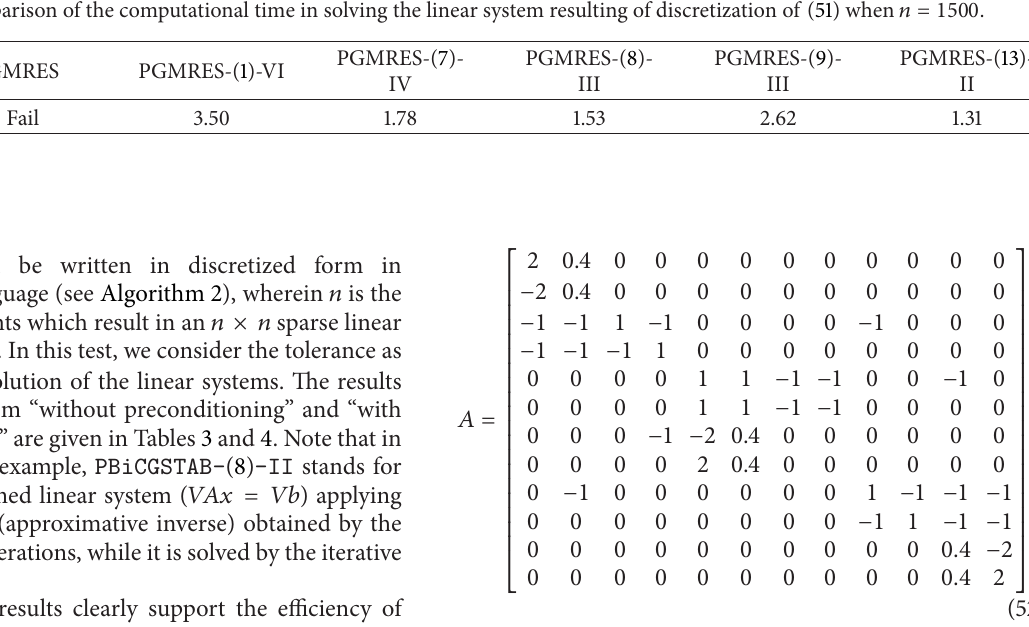
Table [ N [ (Subscript [ w, i − 1 ] − 2 Subscript [ w, i ] + Subscript [ w, i + 1 ] )/